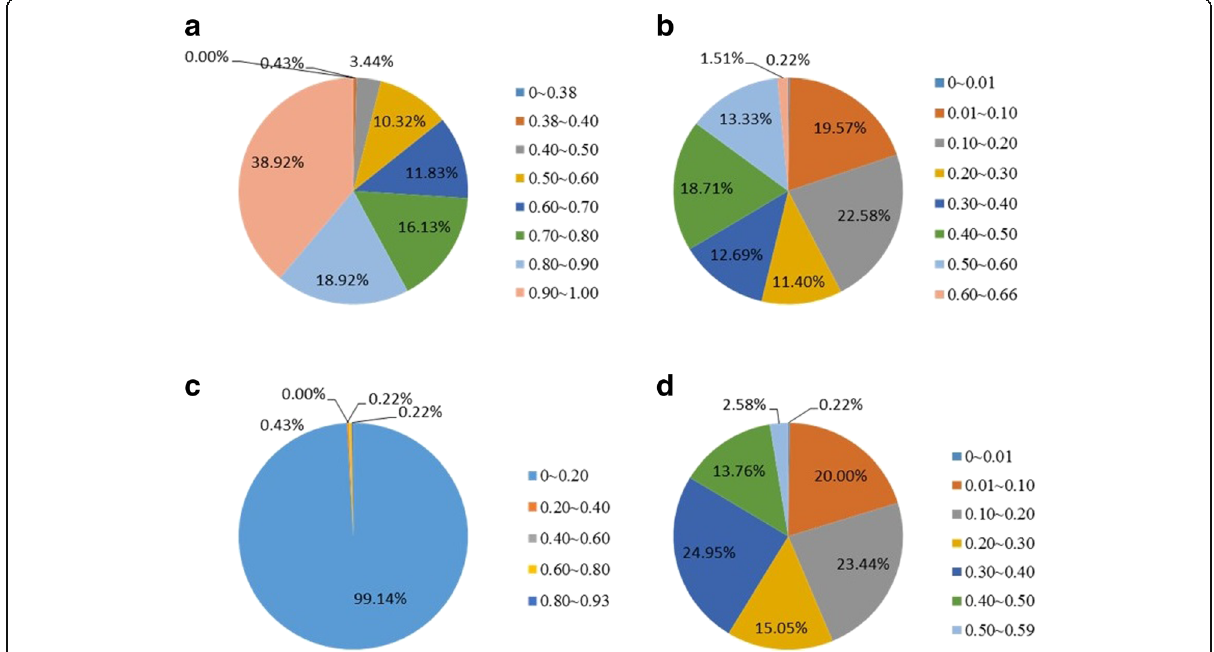
Fig. 3 Genetic diversity of 467 KASP markers a : Minor allele frenquency; b : Gene diversity; c : Heterozygosity; d : Polymorphism information content